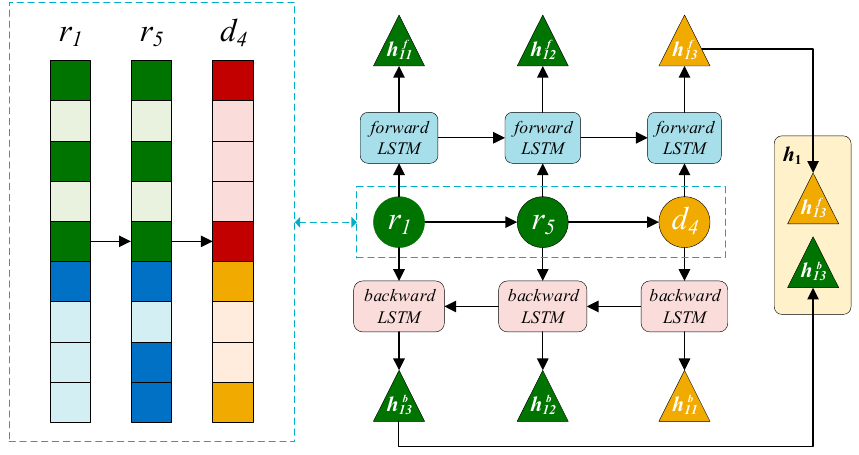
Figure 5. Learning process of the path representation in the BiLSTM module.